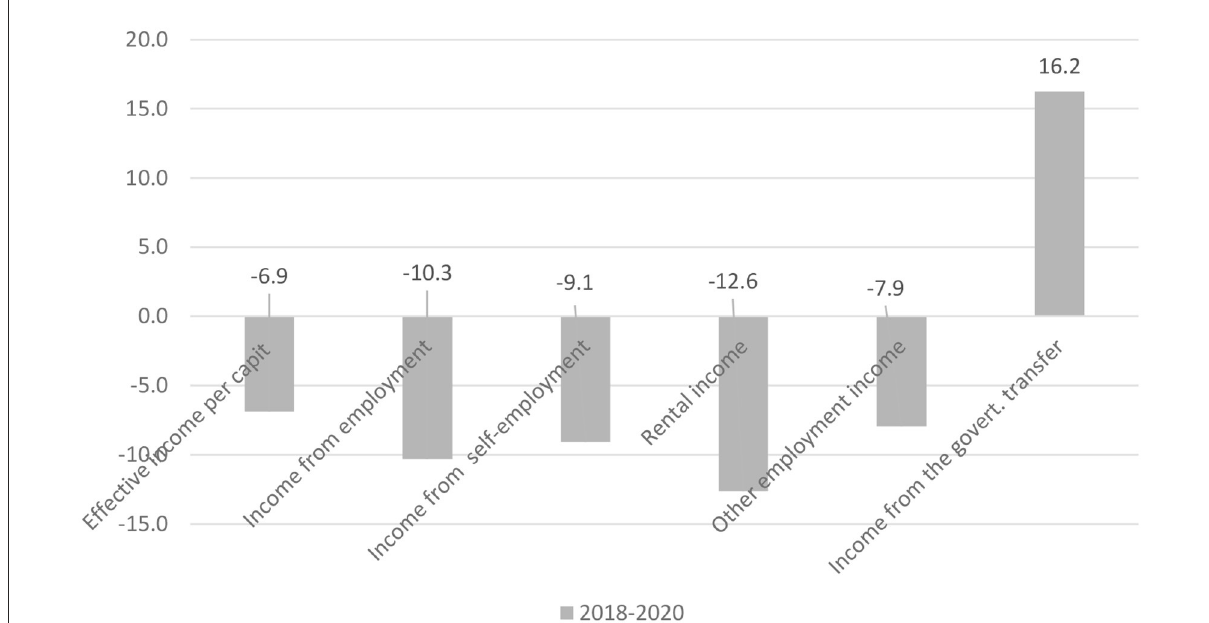
FIGURE5 Change rate of per capita monthly cash income in Mexico (comparison of data in the same month of 2020 and 2018, %). Source: Calculation based on the data published by the